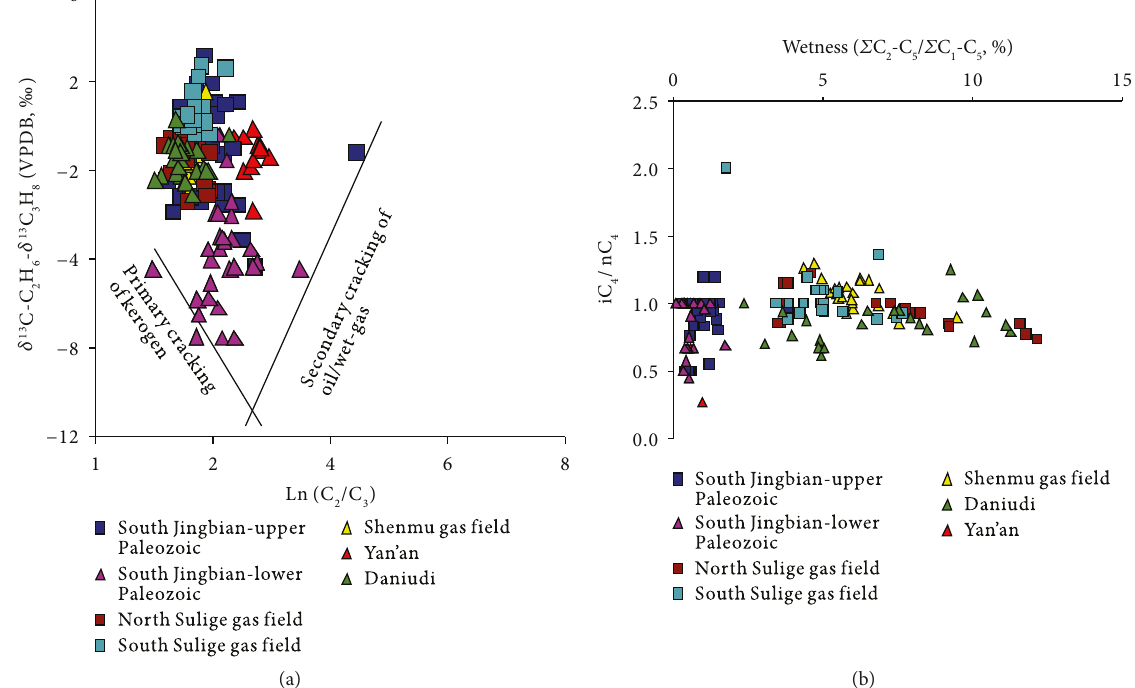
– δ 13 C-C H H and gas wetness (the trending line for primary cracking and secondary cracking 2 6 3 8 /nC and gas wetness (modi fi ed from 4 4